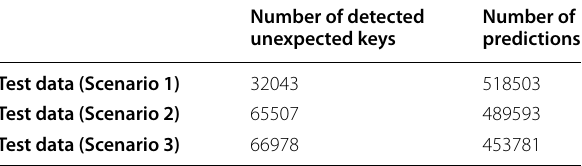
Table 2 Results of evaluating our model with 10-fold cross- Table 3 The number of detected unexpected keys along with the total number of predictions made by our model for the three